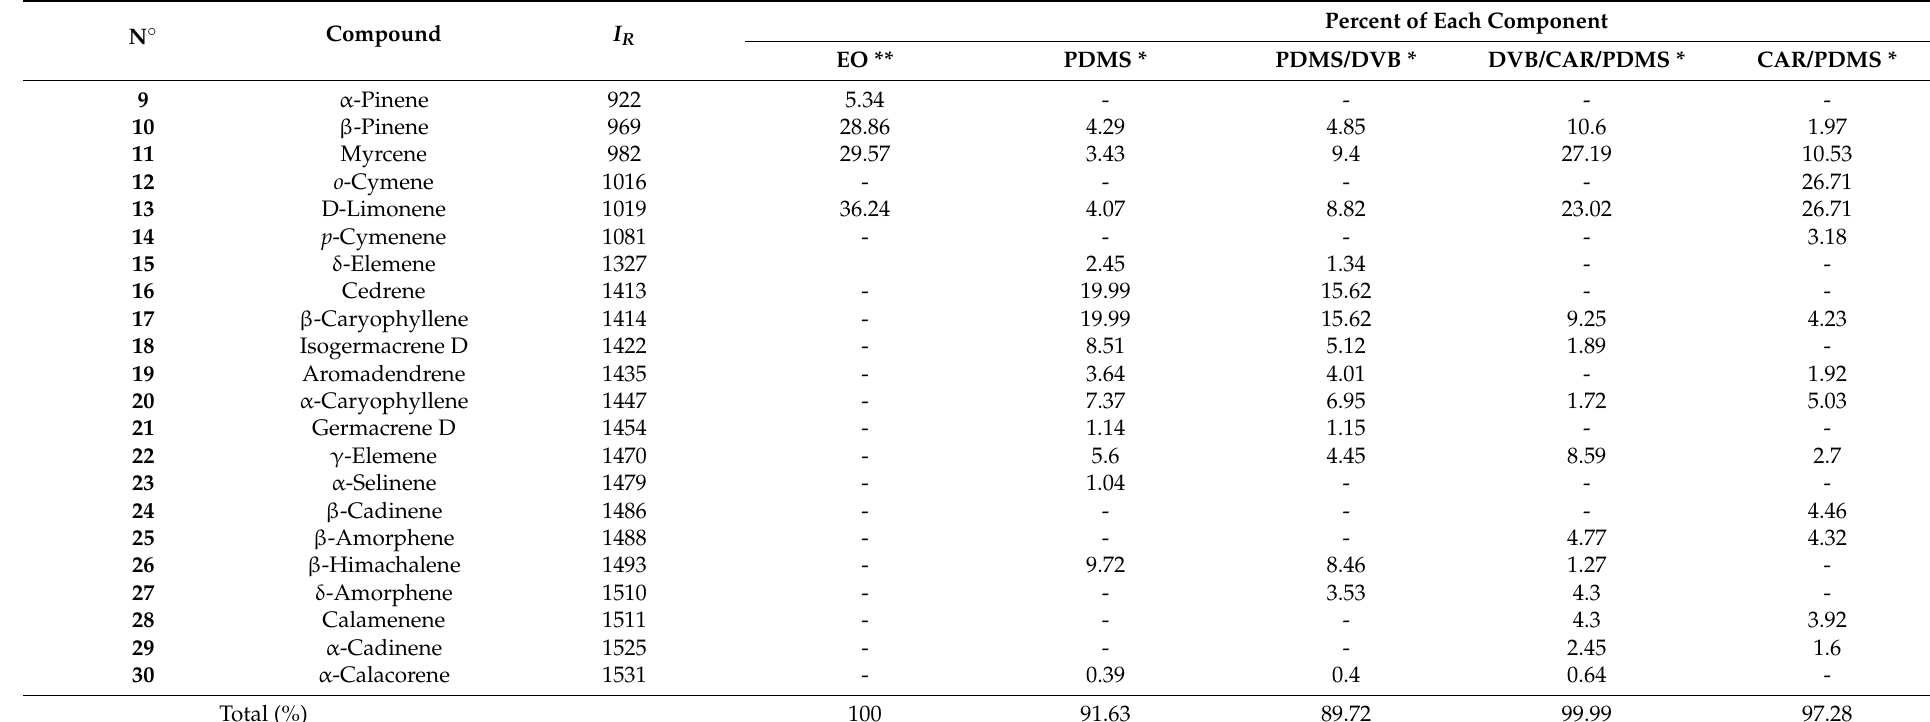
Table 1. Volatile constituents from B. heterophylla identified by GC-MS obtained by HS-SPME using different fibers and by